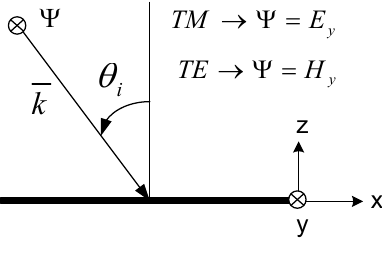
Figure 4: Convention of TM and TE